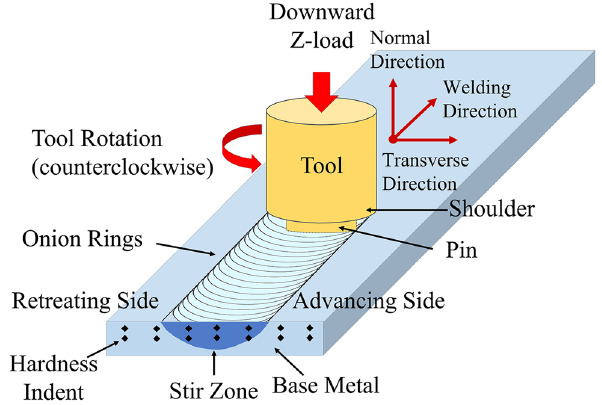
Figure 3: Schematic illustration of bead - on - plate friction stir